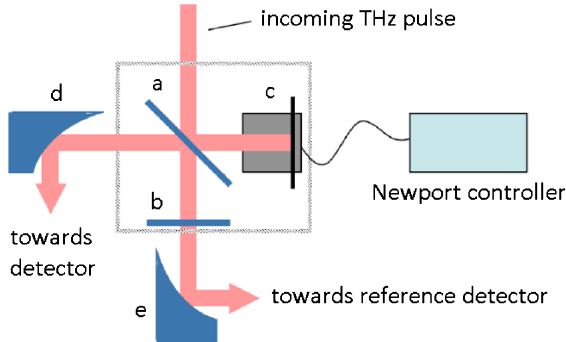
FIG. 21. Schematic of the interferometer, including the follow- ing components: 45° beam splitter (a), 90° beam splitter (b), front surface mirror on a translation stage (c), detector focusing mirror (d), and reference detector focusing mirror